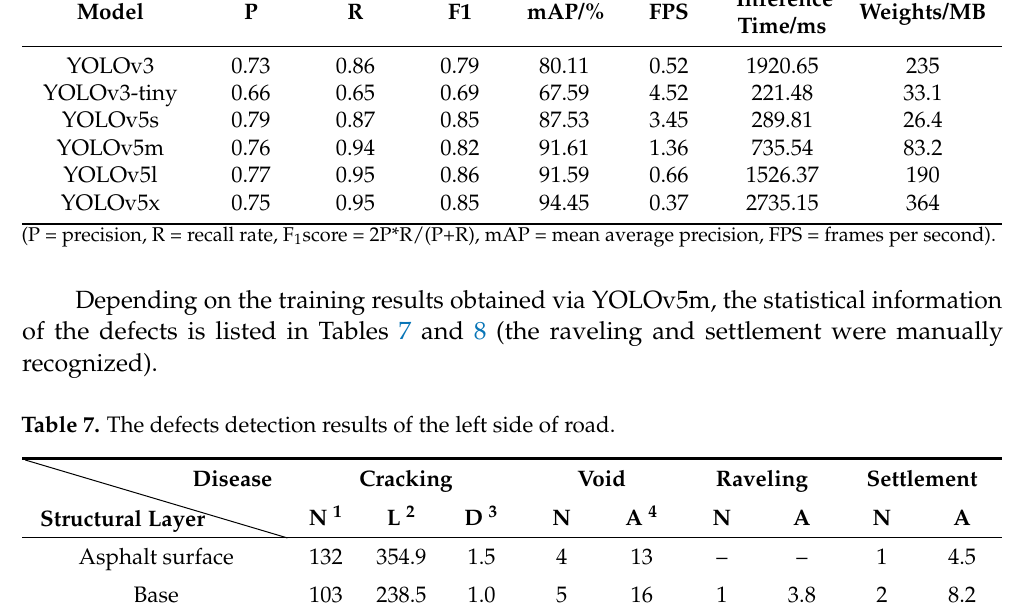
Table 8. The defects detection results of the right side of road.